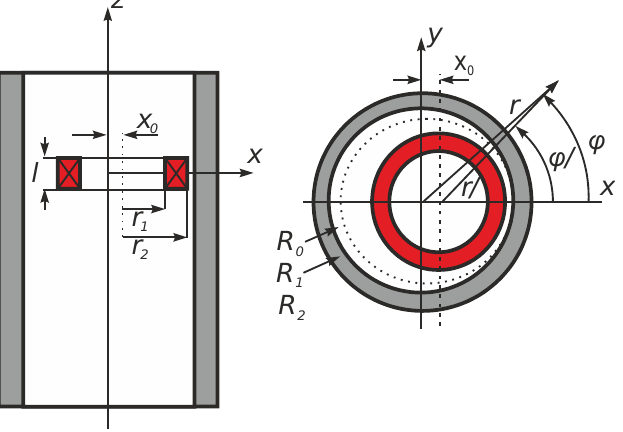
Figure 12. Wobble simulation: a bobbin coil in an offset position to a tube (adapted from [34]).